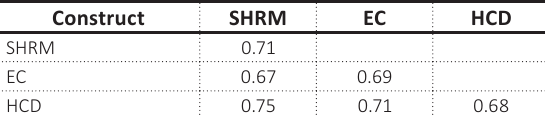
Table 6. Discriminant validity for all constructs